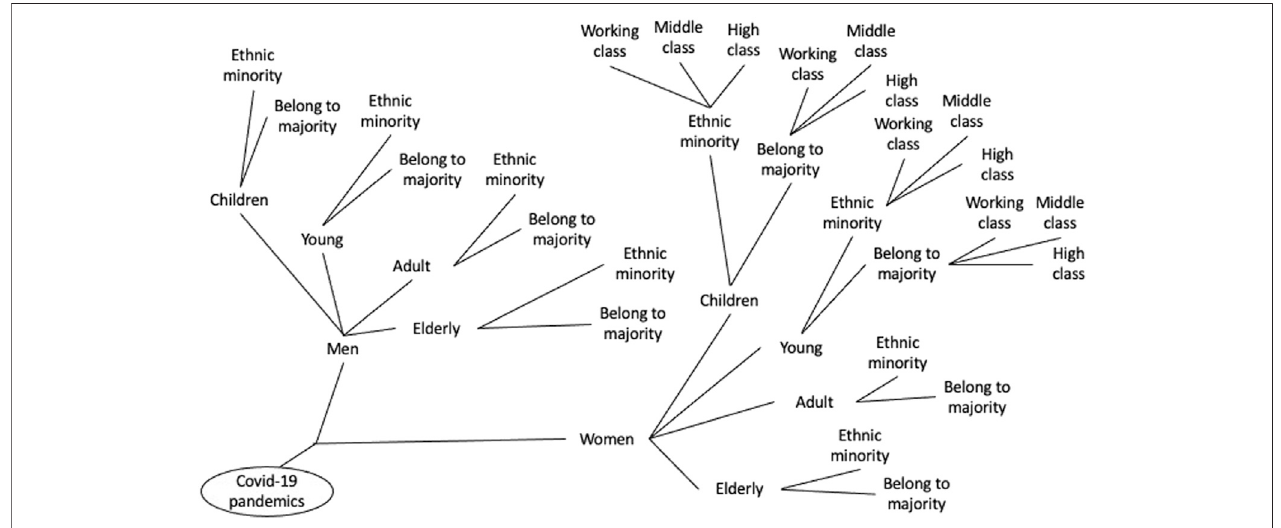
FIGURE 1 | The fi gure represents in a simpli fi ed way the logical reasoning behind applying an intersectional approach to a social phenomenon, such as Covid-19.